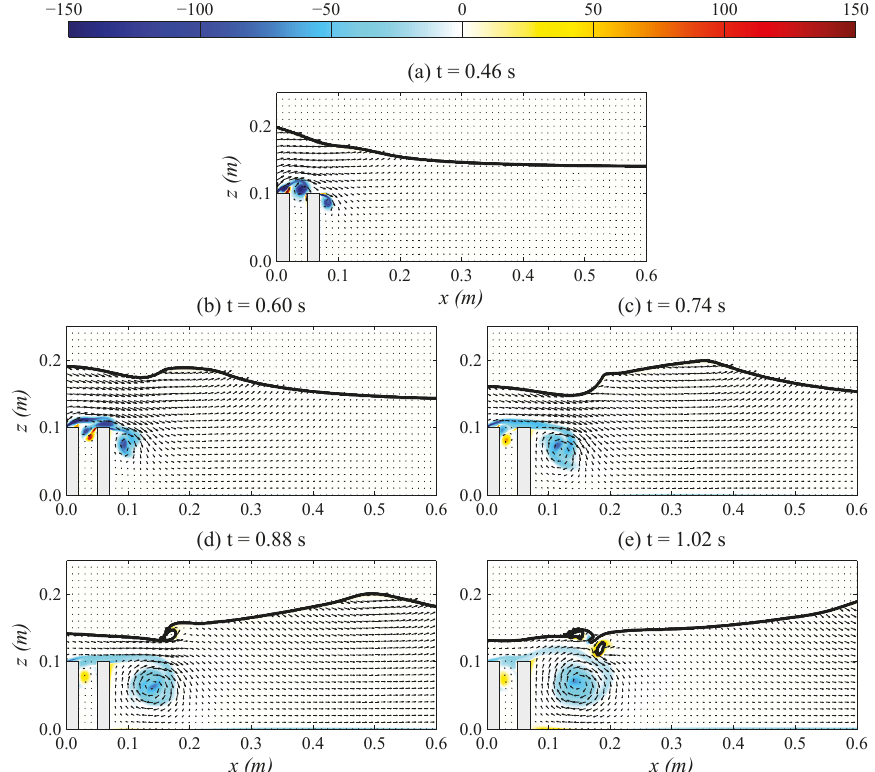
Figure 5. Simulated evolutions of the free surface elevation, velocity and vorticity (unit: s –1 ) (color map) fields for the case of D = 0.05 m at five time instants: ( a ) t = 0.46 s; ( b ) t = 0.60 s; ( c ) t = 0.74 s; ( d ) t = 0.88 s; ( e ) t = 1.02 s.